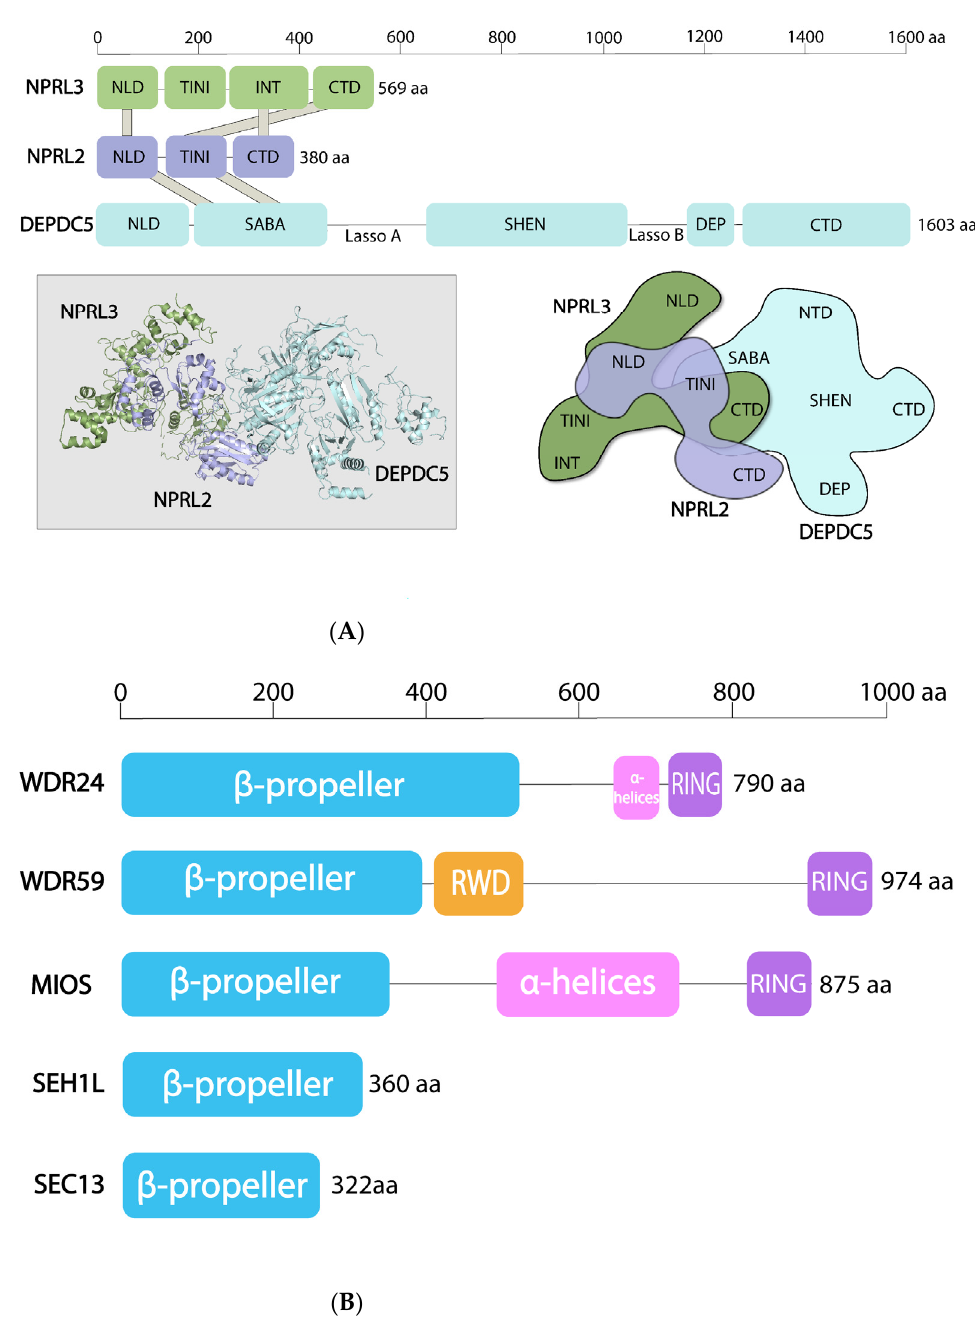
Figure 2. Domain organization of GATOR1 and GATOR2 proteins. ( A ) Domain structure and interaction of GATOR1 proteins (top); atomic model of GATOR1 complex (PDB:6CET), adapted from [29] and modified by PyMOL (bottom left) and cartoon representation of GATOR1 structure with domains indicated (bottom right). ( B ) Schematic representation of GATOR2 components, with domain boundaries according to secondary structure predictions from